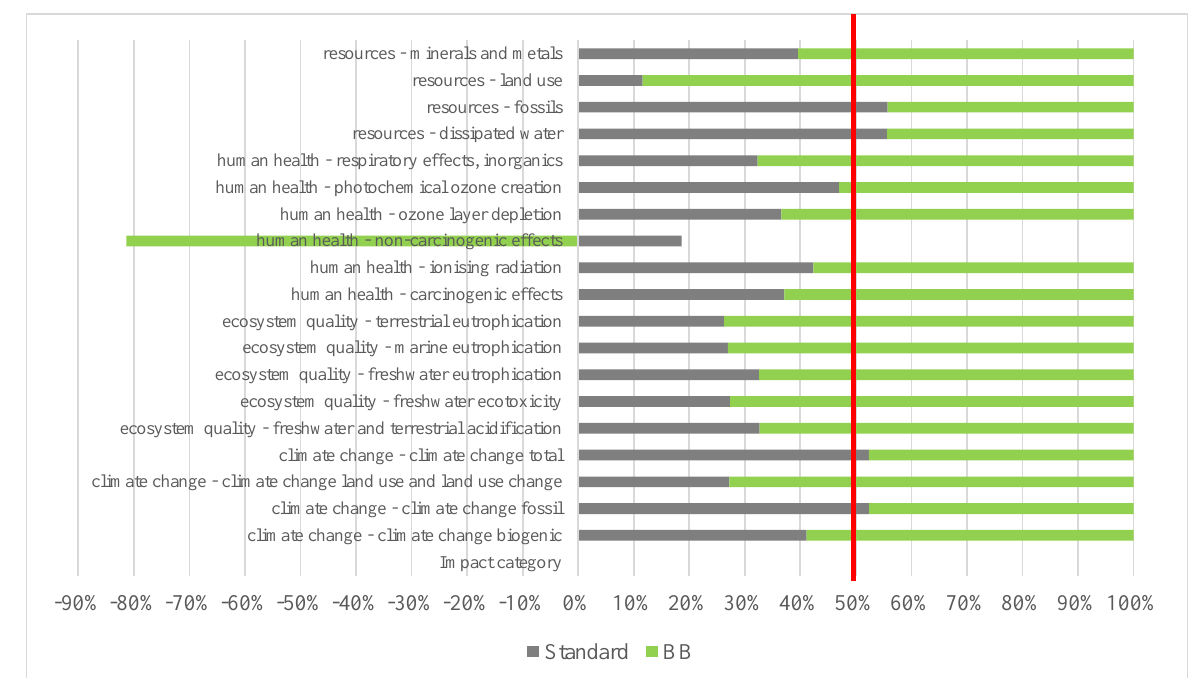
Figure 4. Contribution of standard product and BB product to LCA’s impact categories.